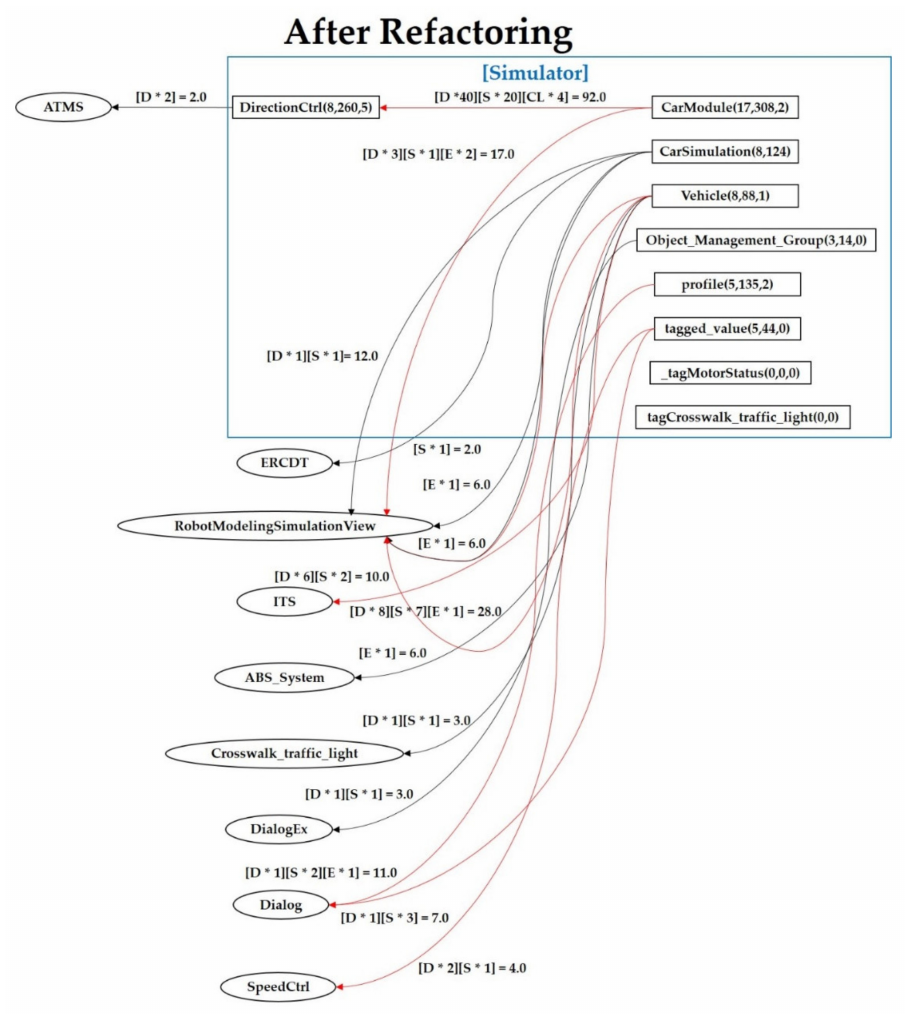
Figure 17. Improved